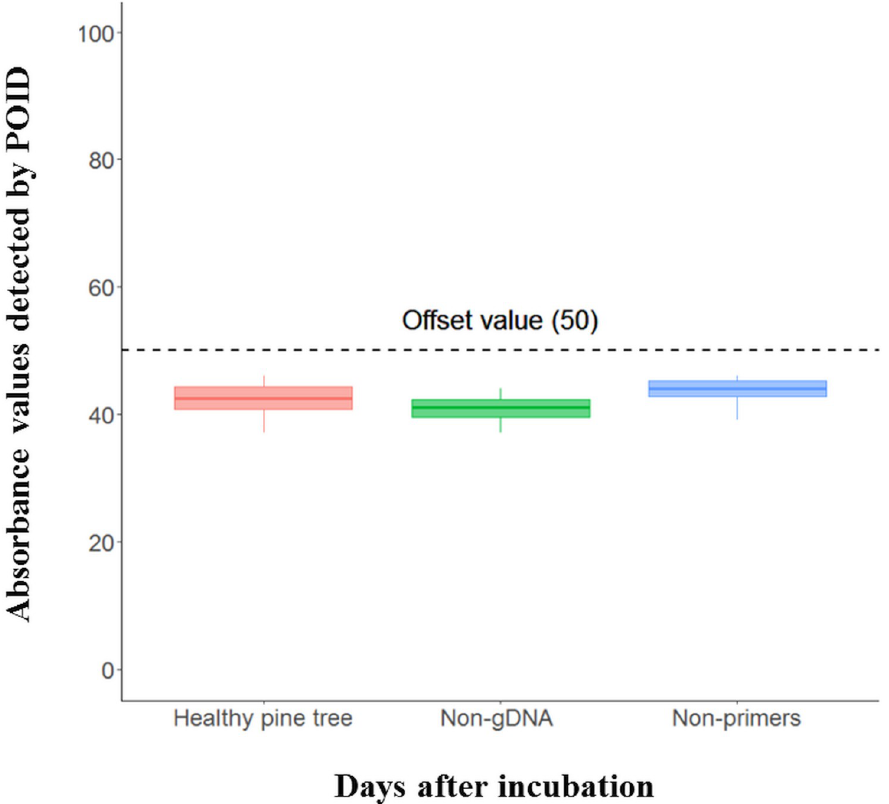
Fig 3. Estimation for the zero absorbance point (offset value) of the portable optical isothermal device (POID) of the RPA assay for the detection of B . xylophilus in pinewood. Healthy pine tree indicates that the used gDNA template was lysate extracted by the DAP buffer from the healthy pine tree. The non-gDNA and non-primers represent that the RPA assay used H 2 O instead of gDNA or primers. The black dashed line represents the offset value of the RPA